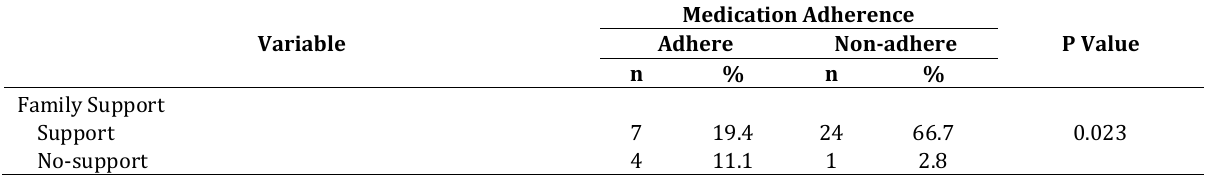
Table 2. Family support related to medication adherence for Schizophrenia patients (n =